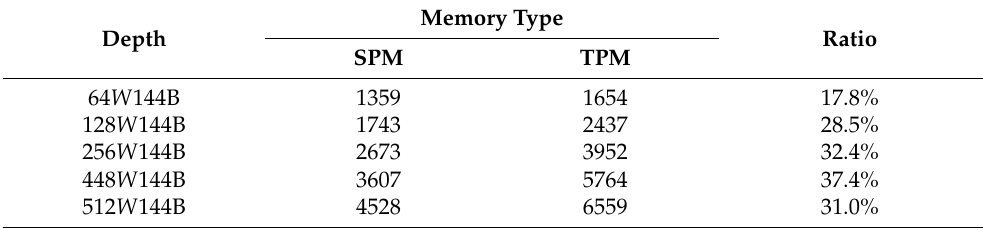
Table 1. The influence of different banks on space overhead.